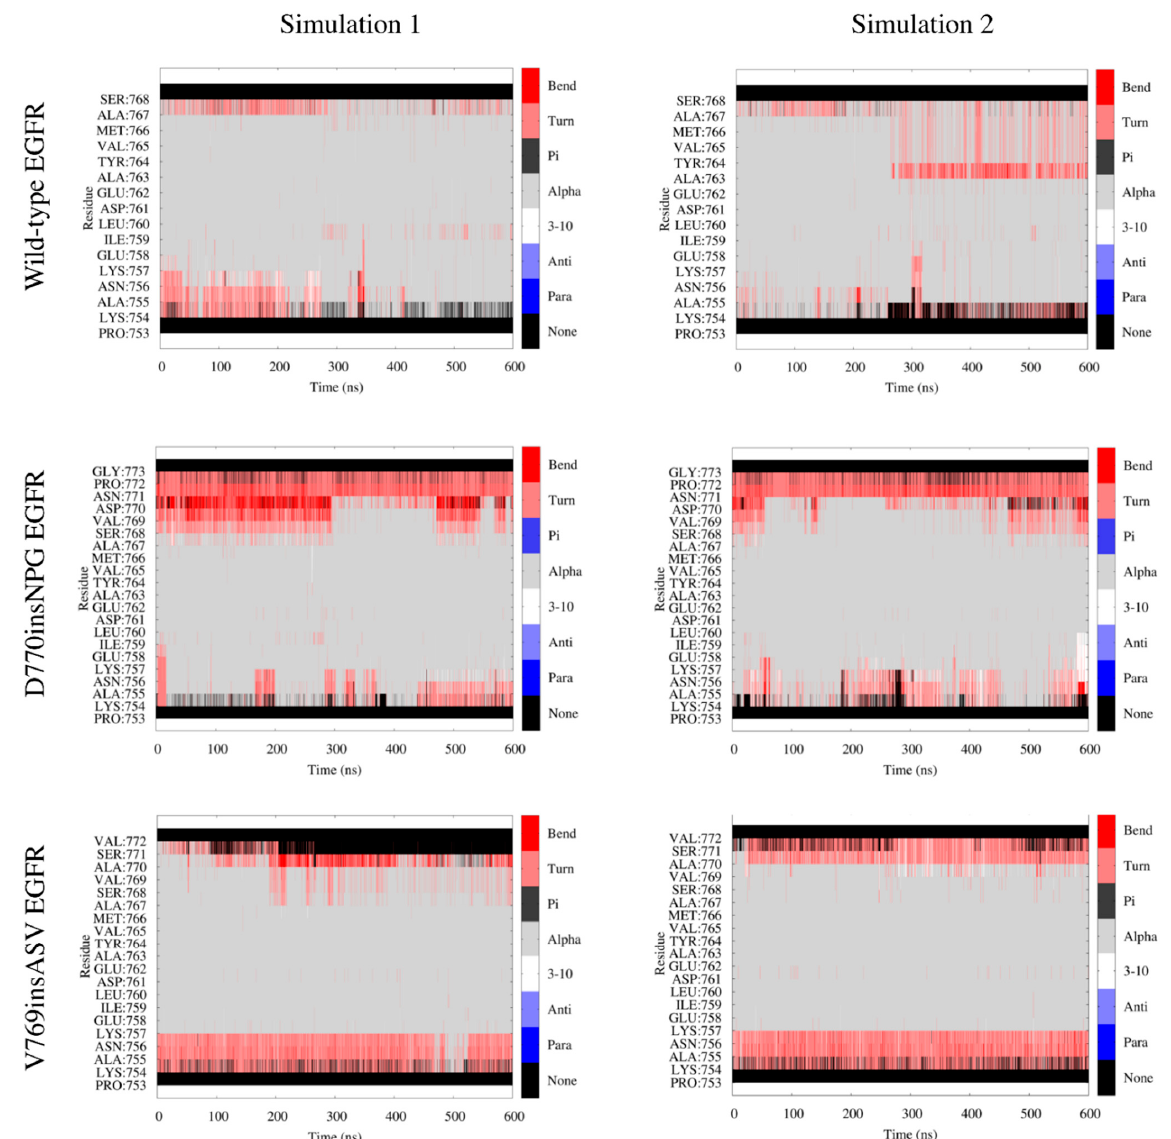
Figure 5. Secondary structure representation of individual residues along the α C helix (inserted residues also shown) during the duplicate simulations of the wild-type (residues 753–768), D770insNPG (753–773) and V769insASV (753–772) EGFRs. The helical structure of the central and C-terminal end of the α C helix was more conserved in the insertion mutants, whereas wild-type EGFR displayed turns and bends during the simulations. Residues at the N-terminal end of the α C helix largely attained turns in all three EGFRs.